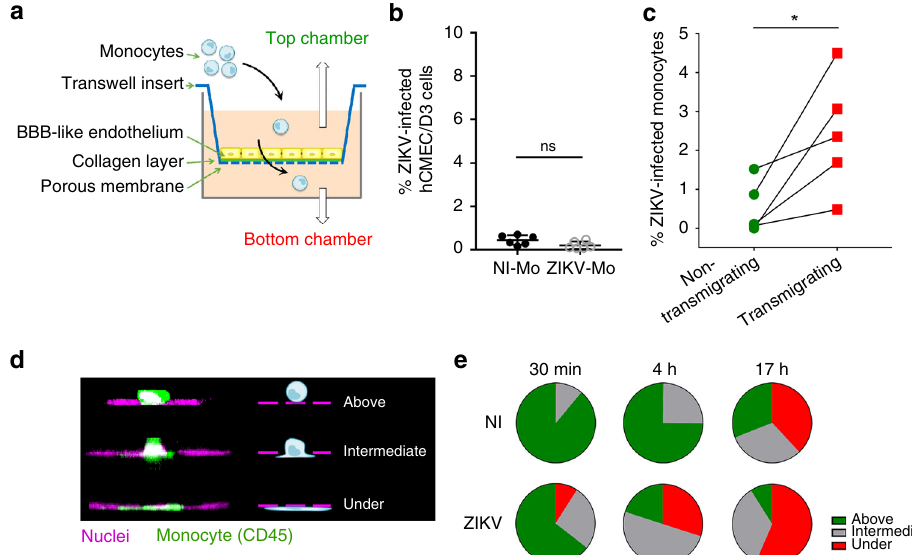
Fig. 4 ZIKV-infected monocytes exhibit higher transmigration properties. a Representative scheme of the transwell transmigration assay. b After a transmigration assay was performed, the hCMEC/D3 monolayer was harvested from the transwell membrane, fi xed, and processed for fl ow cytometry. The cells were stained with a NS2B antibody to assess for viral infection. The graph shows the mean ± SD of two independent experiments done in triplicate with two donors. c Monocytes were noninfected or infected with ZIKV at MOI 1 for 48 h. Upon extensive washes, monocytes were added on top of a transwell insert onto which hCMEC/D3 endothelial cells were plated 7 days before addition. Transmigration was allowed to occur for ≈ 17 h. Monocytes from the top and bottom chambers were harvested, fi xed, and stained. Flow cytometry analysis was performed to determine the percentage of ZIKV- infected cells (NS2B + ) among the monocytes that did not transmigrate (top, green circles) or did transmigrate (bottom, red squares). The graph shows two individual experiments from three donors. One of the replicates was not presented, because no infected cells were detected in the top or bottom chambers (see Source Data fi le for details). Monocytes from the top and bottom come from the same transwell. The fold change of the percentage of infected cells in the top and bottom chambers was signi fi cantly greater (two-way Anova = 0.039). d – e ZIKV-infected or noninfected (NI) monocytes isolated from two donors were cocultured for 17 h with a hCMEC/D3 monolayer previously grown on glass coverslips for 7 days. Upon fi xation and staining with a fl uorescently labeled anti-CD45 antibody, the number of monocytes located above, intermediate, or under the endothelial layer (as depicted in d ) was quanti fi ed by confocal microscopy. e The pie charts correspond to the number of monocytes counted per ten fi elds of view from two individual experiments with two donors. Two-tailed p value < 0.05 (*). Statistical signi fi cance was determined by using a t test. NI noninfected, ns nonsigni fi cant. Source data in b , c , e are provided as a Source Data fi zebra fi sh embryos could represent a suitable alternative. To this speci fi c for ZIKV, since infection with HIV-1 and treatment with end, we developed a novel quantitative xenotypic system based on hGM-CSF did not result in such an increase (Fig. 5f). cells in the zebra fi sh embryo bloodstream 40,41 . Monocytes were Fig. 6a, we noticed that exposure to ZIKV correlated with an dependent enhancement (ADE) 42,43 (Supplementary Fig. 10). extended spread morphology of the monocytes. Quanti fi cation of the cell ’ s area and circularity upon attachment to endothelial cells in ZIKV-exposed monocytes con fi rmed that ZIKV induces a dramatic spread-out morphology compared with naive mono- cytes (Fig. 6b, c and Supplementary Fig. 9).